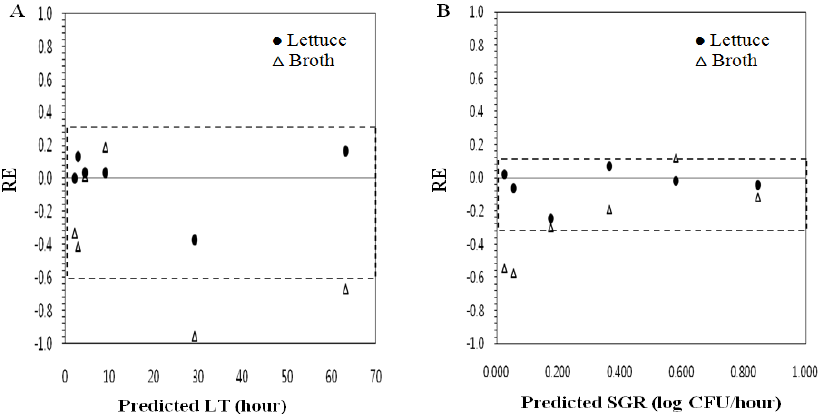
Figure 4. Relative error (RE) plots with an acceptable prediction zone analysis of lag time (LT) and specific growth rate (SGR) data used in evaluation of extrapolation. ( A ) LT. ( B )